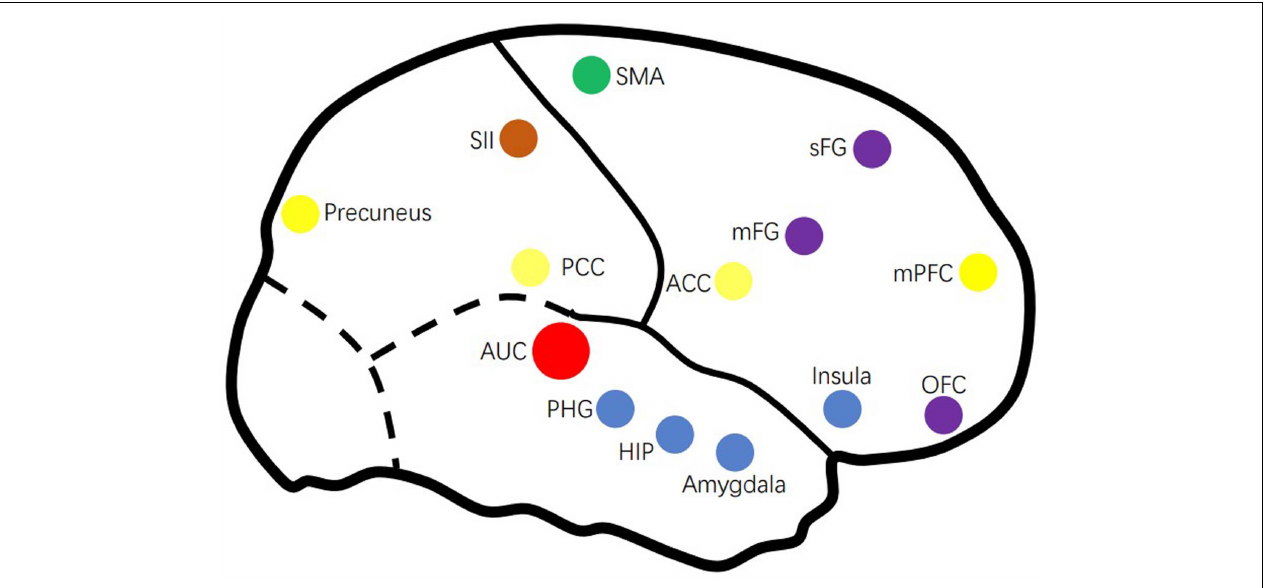
FIGURE 1 | Overview of the tinnitus-related brain areas based on fMRI. AUC, auditory cortex; ACC, anterior cingulate cortex; HIP, hippocampus; mFG, medial frontal cortex; mPFC, medial prefrontal cortex; OFC, orbitofrontal cortex; PCC, posterior cingulate cortex; PHG, parahippocampus; sFG, superior frontal gyrus.